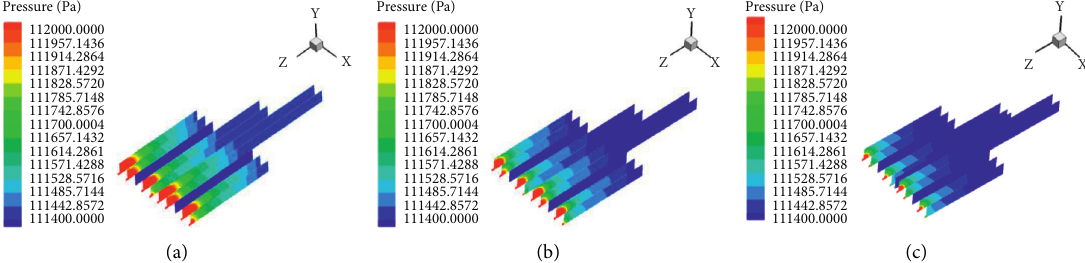
Figure 12: Simulation results of longitudinal slices at different air inlet pressures. (a) At air inlet pressure of 112,400 Pa. (b) At air inlet pressure of 112,000 Pa. (c) At air inlet pressure of 111,800Pa.